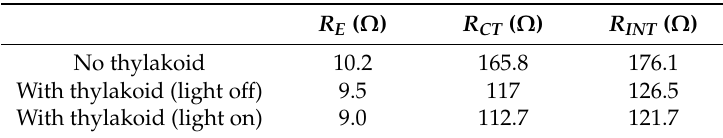
Table 2. Electrolyte resistance ( R E ), charge transfer resistance ( R CT ), and internal resistance ( R INT ) of flat electrodes with different conditions.